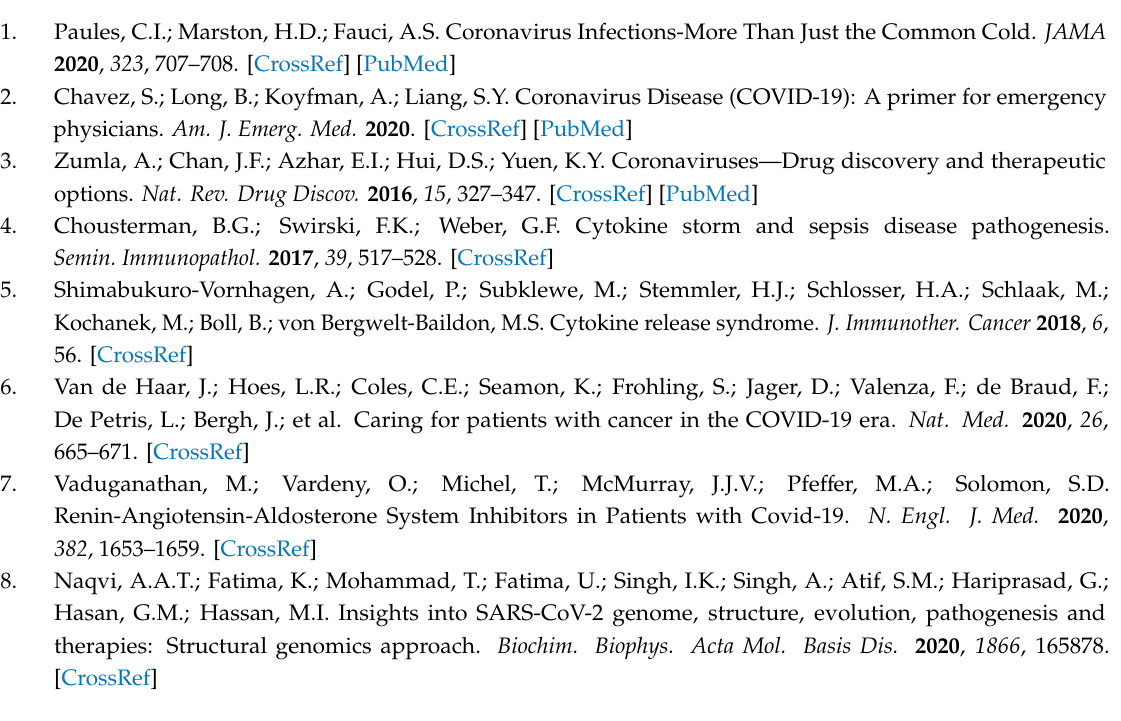
Table S1: Cytokines and immune cells comparison between mild and severe SARS-CoV-2-infected patients. Table S2: Clinical symptoms and other